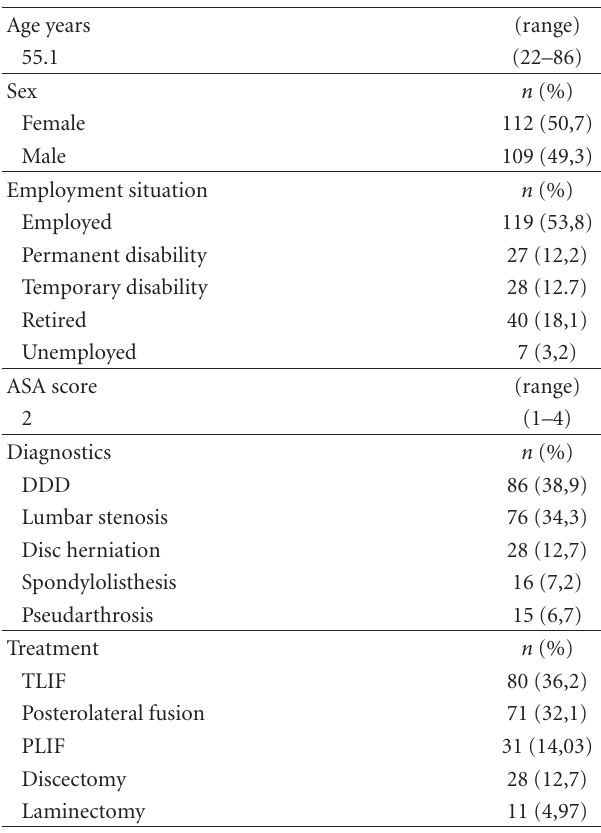
Table 1: Epidemiological data (221